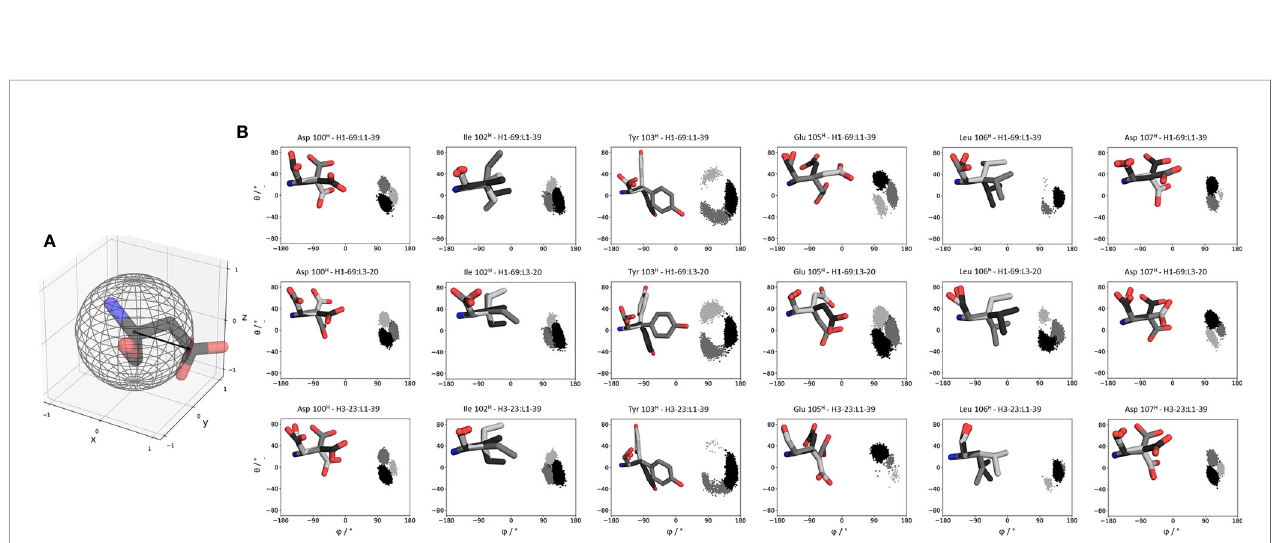
FIGURE 7 | Sidechain fl exibilities of the CDR-H3 loop. (A) Exemplary illustration of an amino acid projected into the sphere from which the polar coordinates ( q and j ) are calculated. (B) The same CDR-H3 loop can adopt pairing speci fi c CDR-H3 loop conformations. Here we provide a detailed analysis of sidechain orientations and which sidechains are strongly in fl uenced by different light and heavy chain pairings respectively. We also color-coded the different sidechain orientations according to their populations: dark grey represents the highest populated sidechain conformation, while in light grey the least populated one is illustrated. On the left, the respective sidechain orientations and conformations are depicted and colored respectively. The X and Y axes show the projection of the vectors on the polar angle and azimuth angle on the surface of a unit sphere (spherical coordinates). This allows to determine not only the fl exibility of the sidechain but also the orientation. A more detailed description can be found in the methods